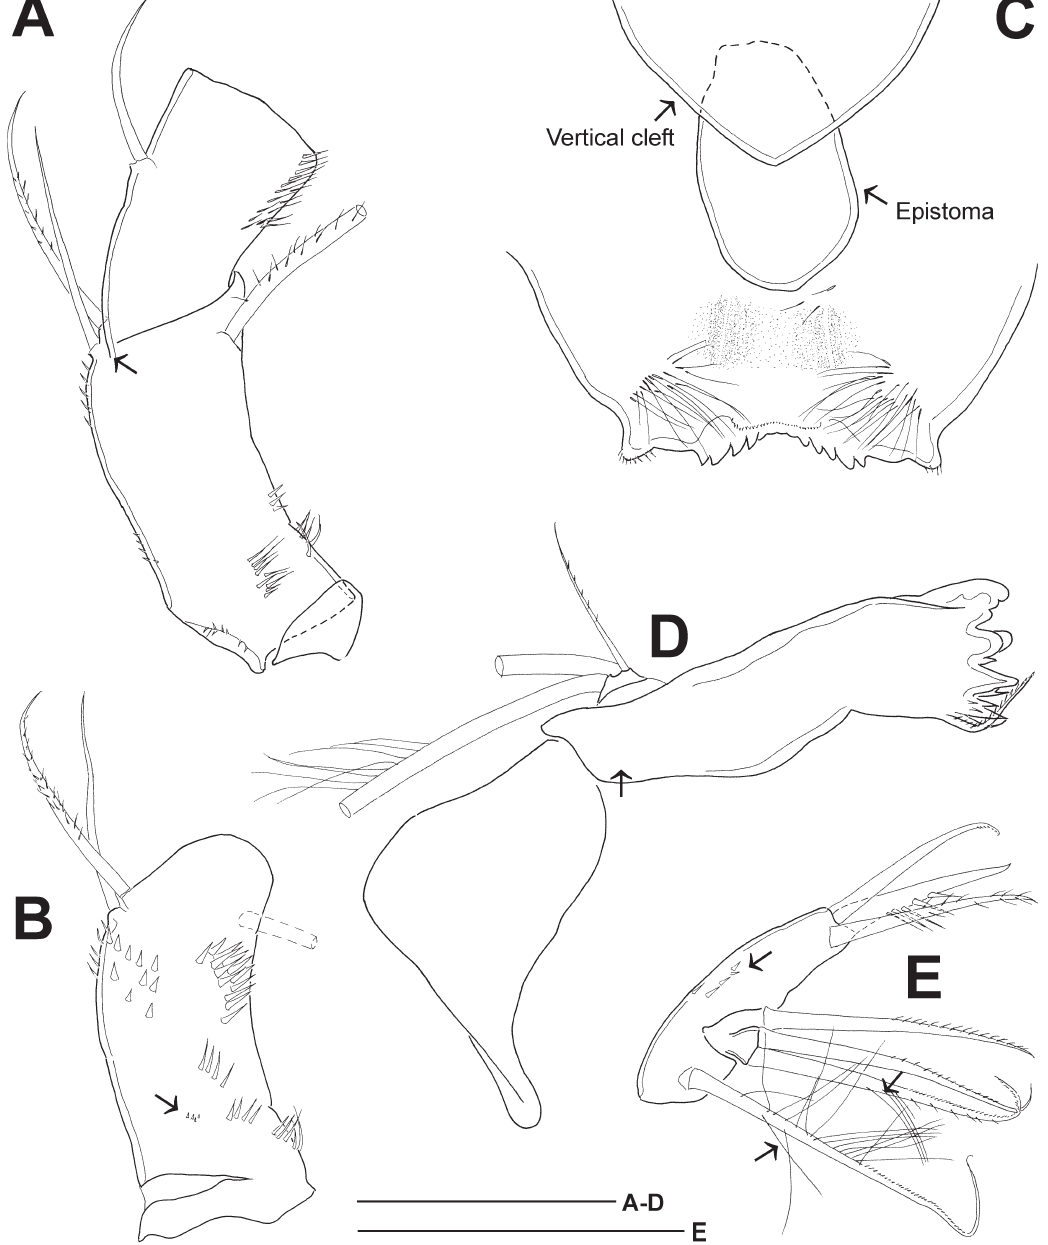
Fig. 2. Cyclops bohater koźmiński, 1933, ♀. A−B . surface ornamentation of antennal coxobasis. A . Frontal, arrow points to insertion site of long spinules missing in C. bohater . B . caudal, arrow points to a group of spinules sometimes present. C . Labrum, epistoma and rostrum. D . mandible, frontal, arrow points to insertion site of spinules missing in C. bohater . E . maxillulary palp, arrows point to long setules of the setae, and spinulose ornamentation of the palp. all drawings show the lectotype (nHmUk 2016.38). scale bars: a−e =